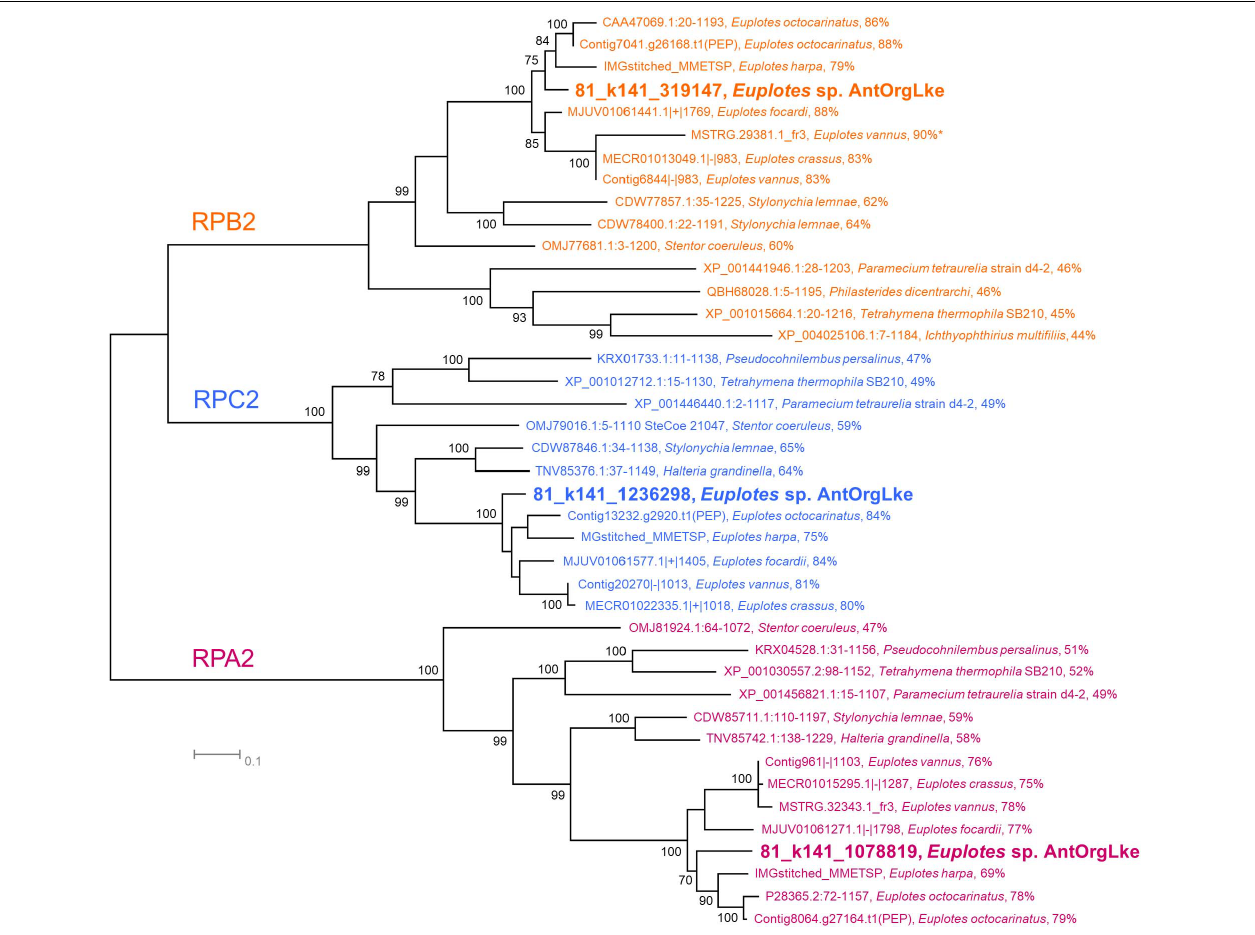
FIGURE 3 | Phylogeny of Euplotes sp. AntOrgLke. Unrooted maximum likelihood phylogeny of RNA polymerase subunit II proteins from members of Ciliophora showing Euplotes sp. AntOrgLke clustering with members of the Euplotes genus. Within the cluster for each RNA polymerase type (RPB, RPC, and RPA), the percent identity between Euplotes sp. AntOrgLke protein and an individual protein is shown after the species name. Bootstrap values ≥ 70 are shown next to individual nodes, and protein sequences are available in Supplementary Dataset 5 . A total of 41 RNA polymerase subunit II amino acid sequences were used in analysis. Positions with less than 80% site coverage were eliminated, and 944 positions remained in the final dataset, with the exception of MSTRG.29381.1_fr3, Euplotes vannus which was a partial sequence (283 aa) and is marked with